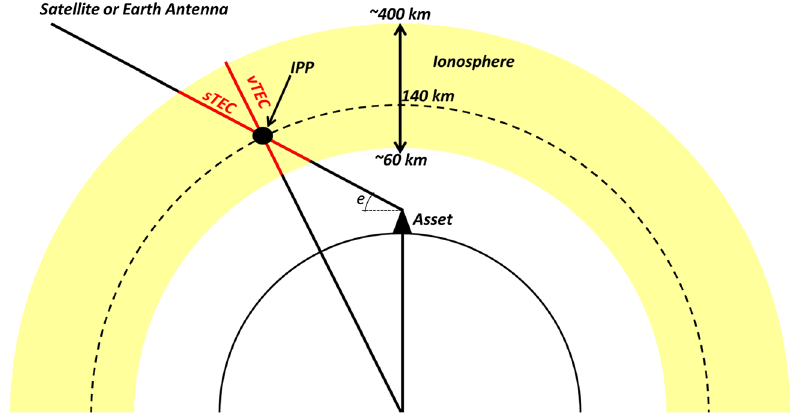
Fig. 9. Projection used to retrieve the sTEC in a line-of-sight from the MoMo vTEC predictions. IPP stands for Ionospheric Pierce Point. e is the elevation angle of the external object with respect to the